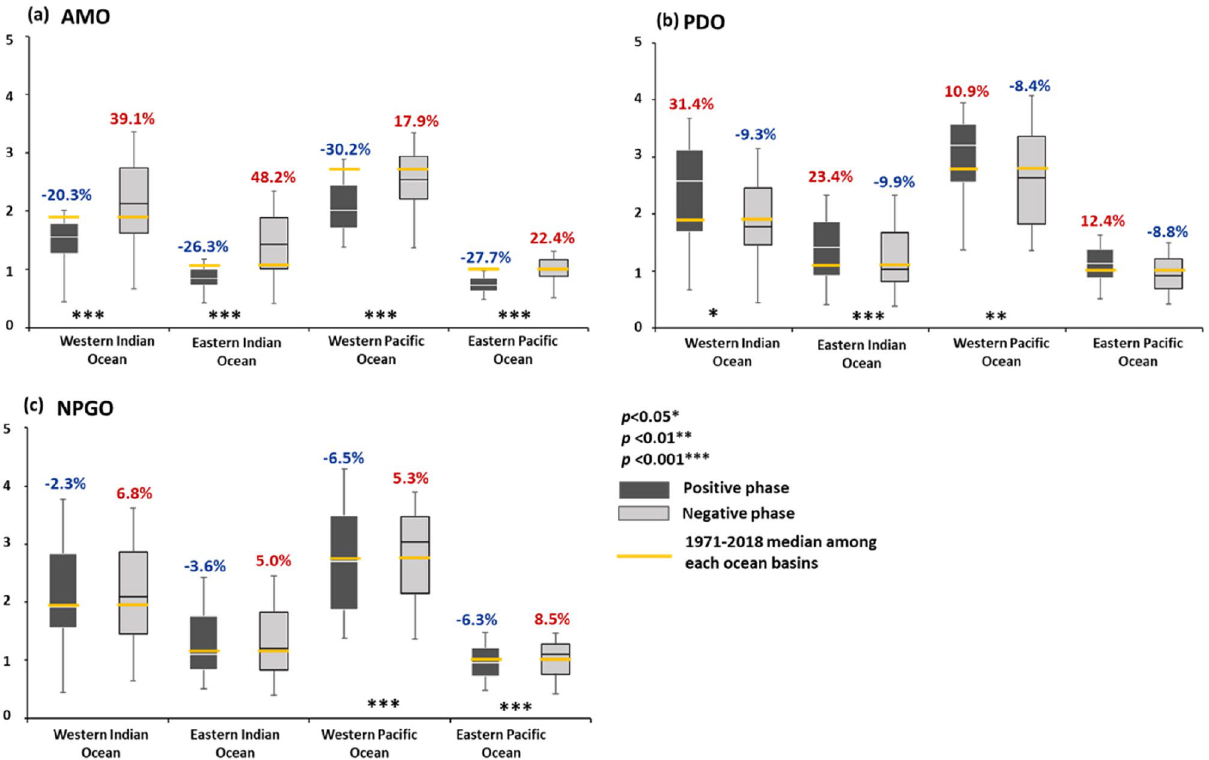
Figure 1. Box plot of each ocean basins’ CPUE values. ( a ) During AMO events. ( b ) During PDO events. ( c ) During positive and negative NPGO events. Values displayed in the figure represent the median increase (red) and decrease (blue) percentages as compared with the 1971–2018